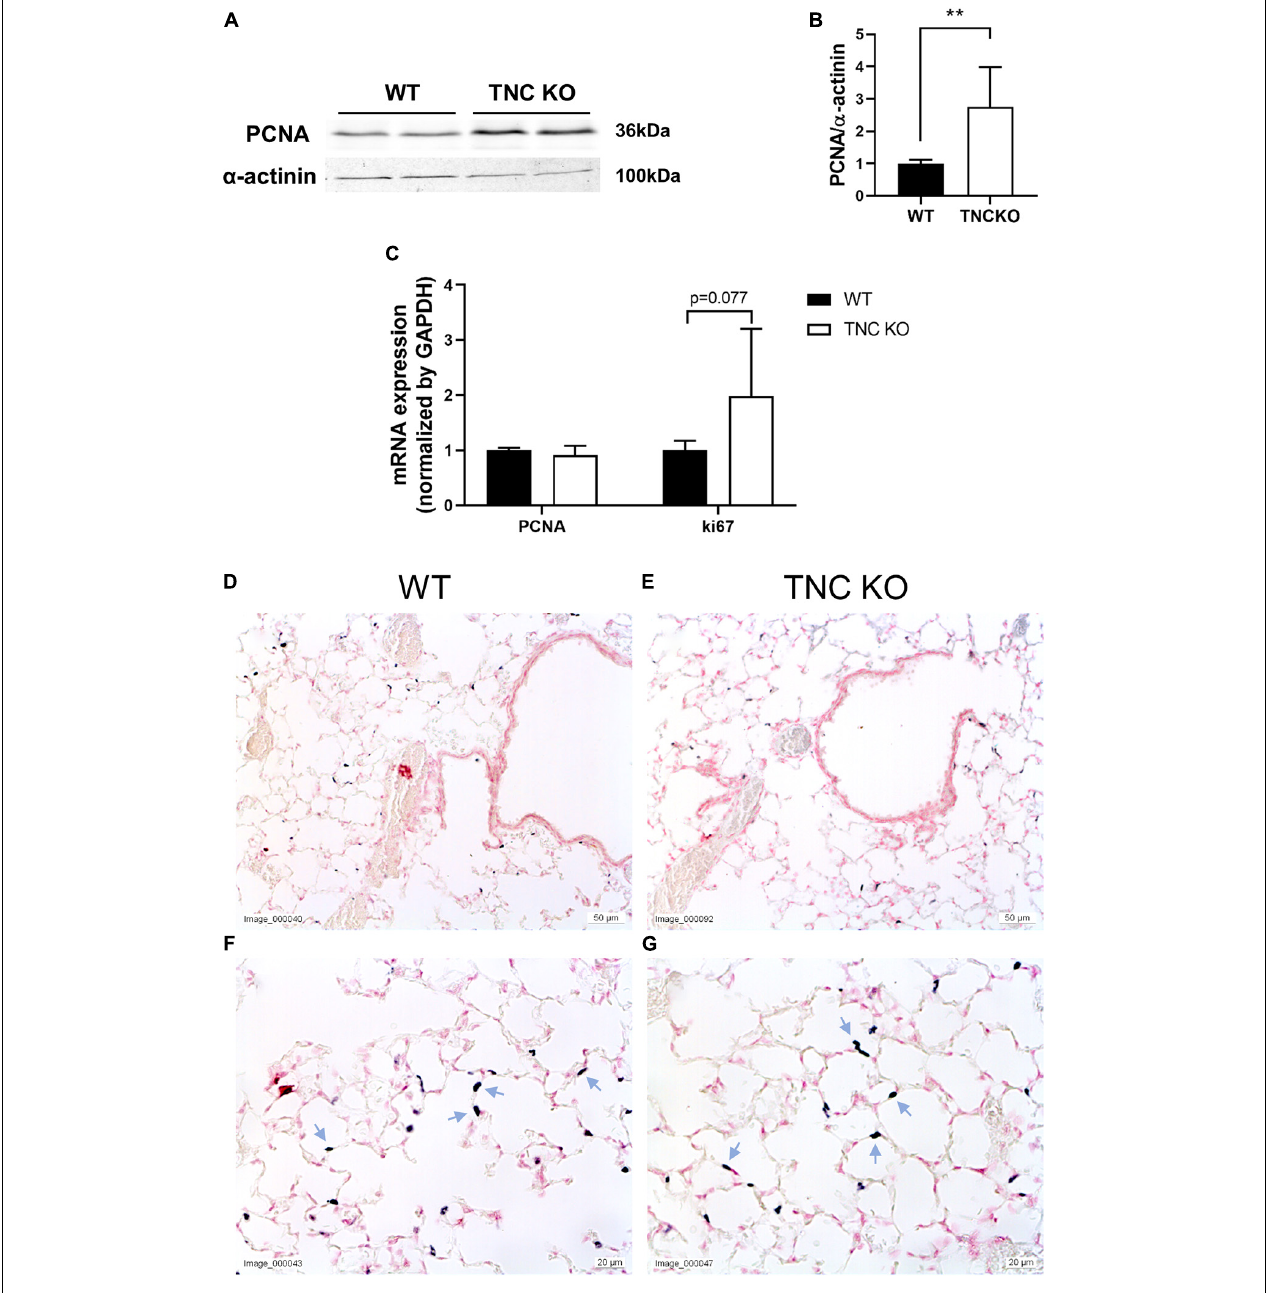
FIGURE 3 | Proliferation markers in old TNC-deficient and WT lungs. (A,B) : representative results of PCNA protein detection in whole lung lysates from old TNC-deficient and WT animals by Western blot; quantification is shown in histogram; N = 6–7 animals/genotype. Cropped blots are displayed. (C) : mRNA expression of PCNA and ki67 evaluated by RT-qPCR from whole lung lobe total RNA extraction of old TNC KO ( (cid:3) ) and WT ( (cid:4) ) animals. N = 6 animals/genotype. (D–G) : representative images of lung sections from TNC KO and WT old animals immunostained with anti-ki67 antibody (dark gray; blue arrows) and counter-stained with Nuclear Red. N = 3–5 animals/genotype. For histograms: results are expressed as mean ± SD; statistical analyses were made by Student’s t test; statistical significance was set at p < 0.05; * p < 0.05, ** p <